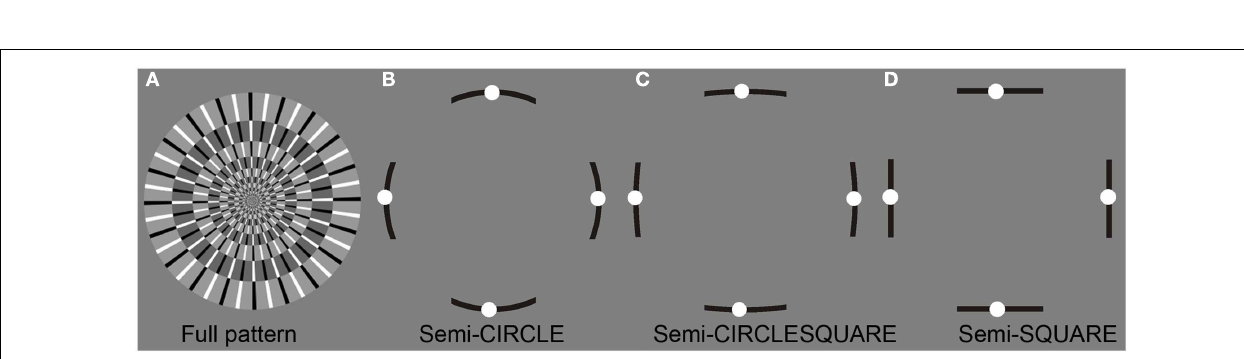
FIGURE 4 |Two types of the standard comparison figure: (A) the full pattern which resembled the pattern of test figures. (B–D) The semi-contour figures with four white dots placed along each of the four contour segments.The contour shape of the semi-contour figure varied with the test